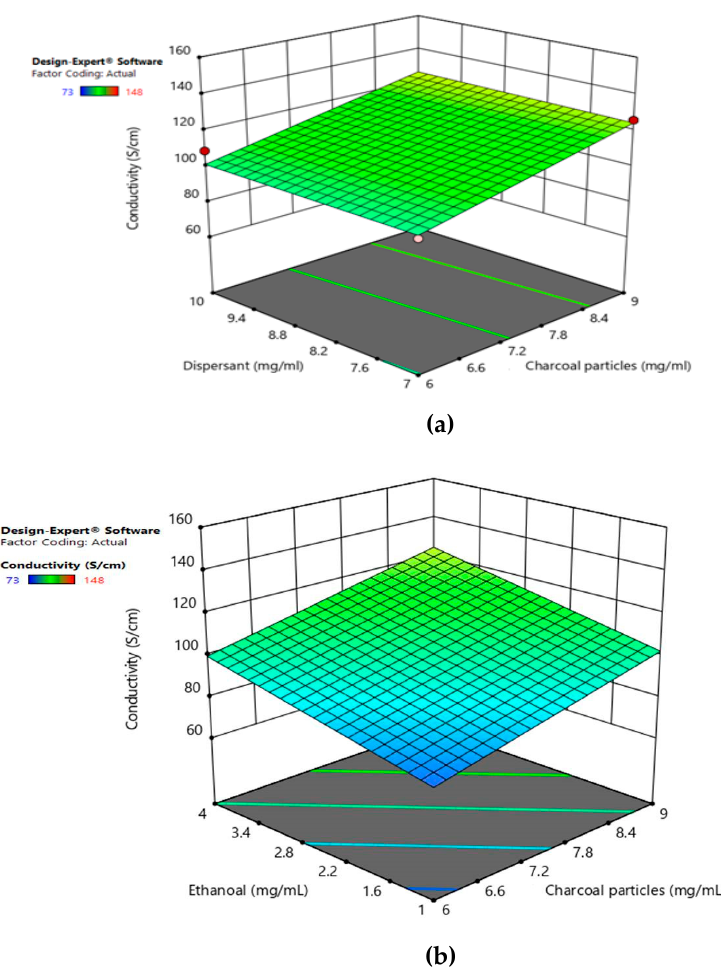
Figure 4. 3D graphical relation of σ with dispersant ( a ) andethanol ( b ) versus charcoal particles.